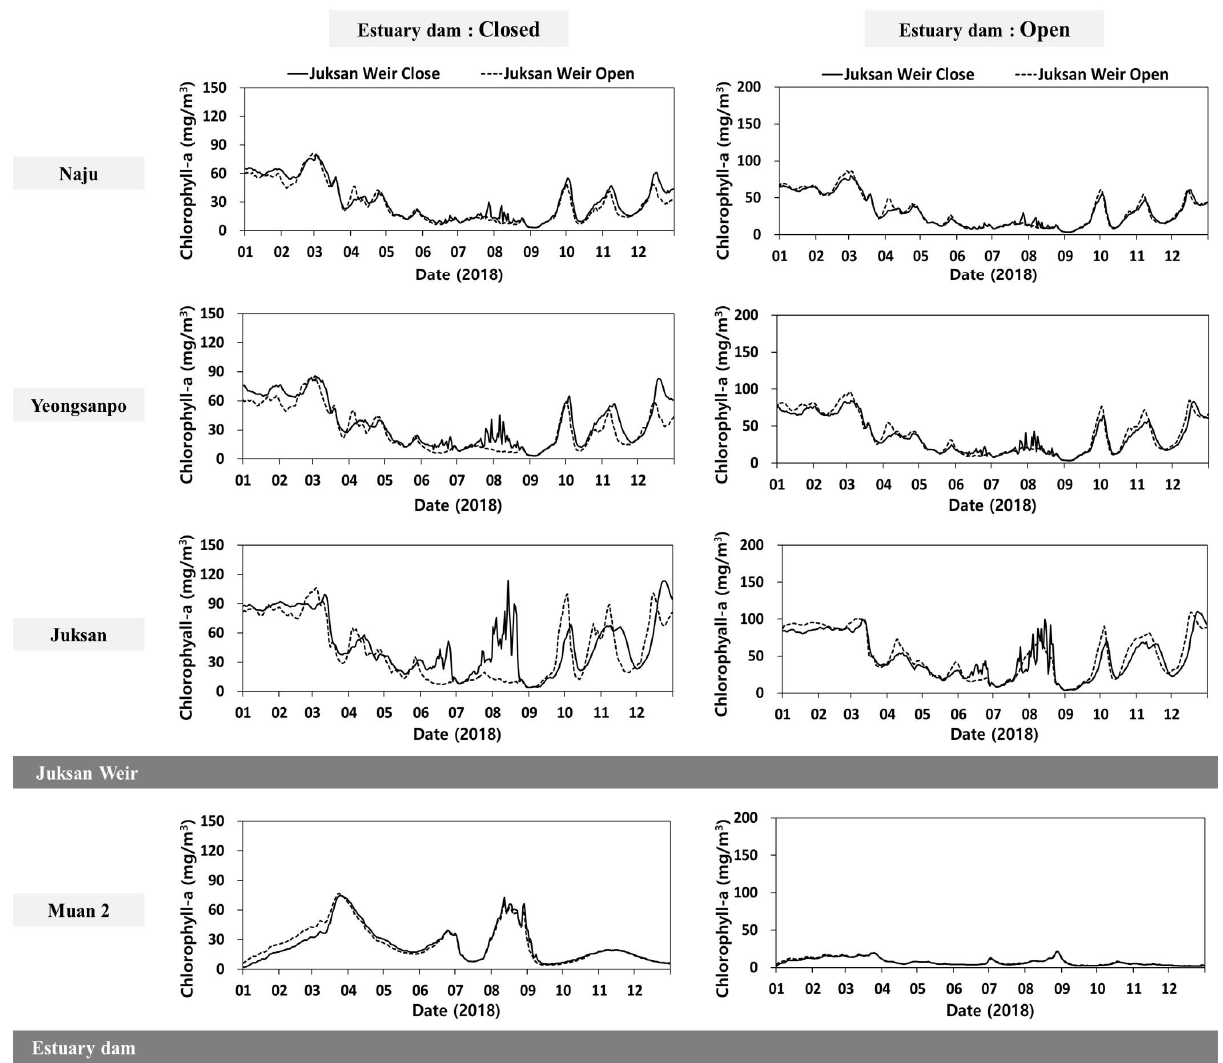
Figure 8. Simulated chlorophyll a concentrations according to the operating conditions of the Juksan Weir and estuary dam.